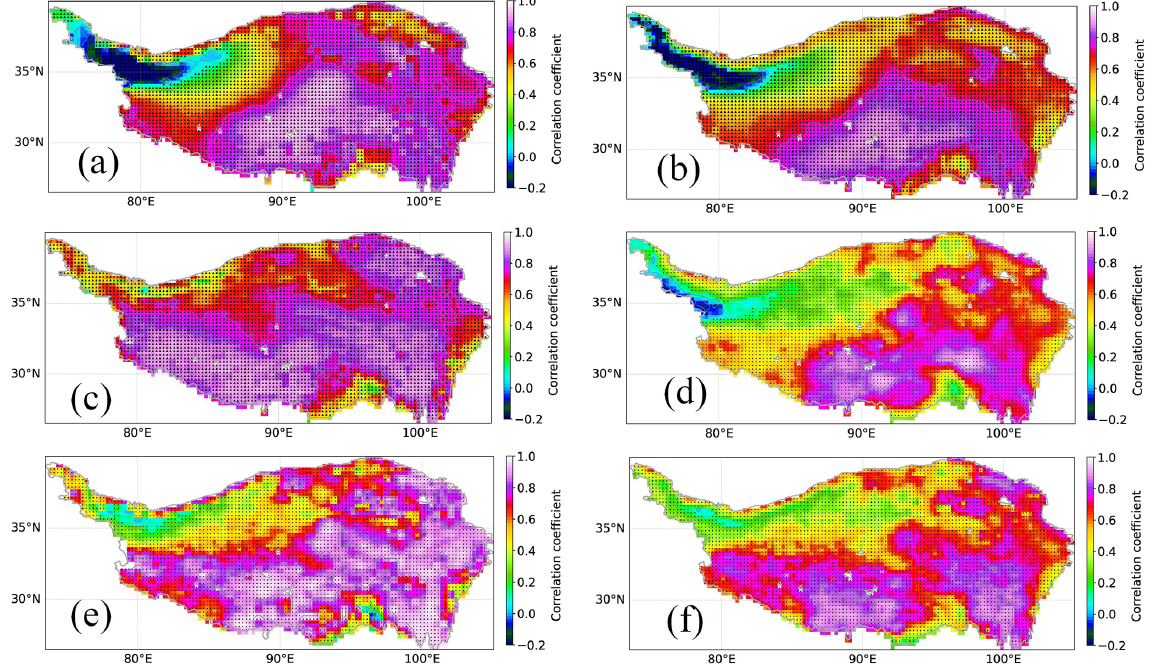
Figure 4. Pearson correlation coefficient between the precipitation of (a) CMA and GLDAS, (b) GLDAS and ERA5, (c) CMA and ERA5, (d) GLDAS and CMFD, (e) CMA and CMFD, and (f) ERA5 and CMFD over the summer period of May–September. The black dots denote the significant ( p < 0.05)